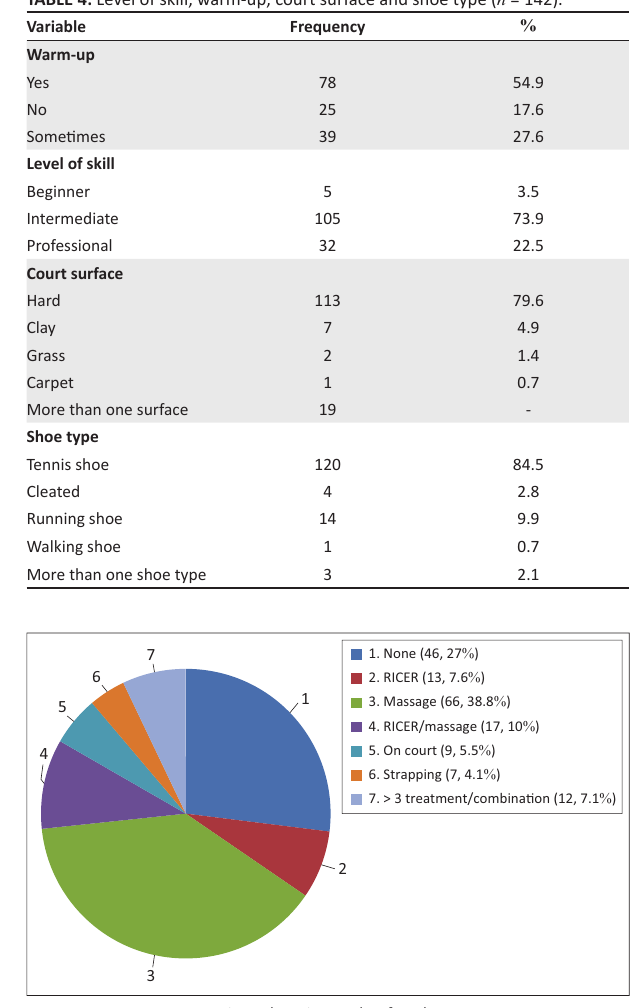
RICER, Rest, Ice, Compression, Elevation and Referral. FIGURE 3: Initial treatment given. physiotherapists and nurses respectively. Figure 2 indicates